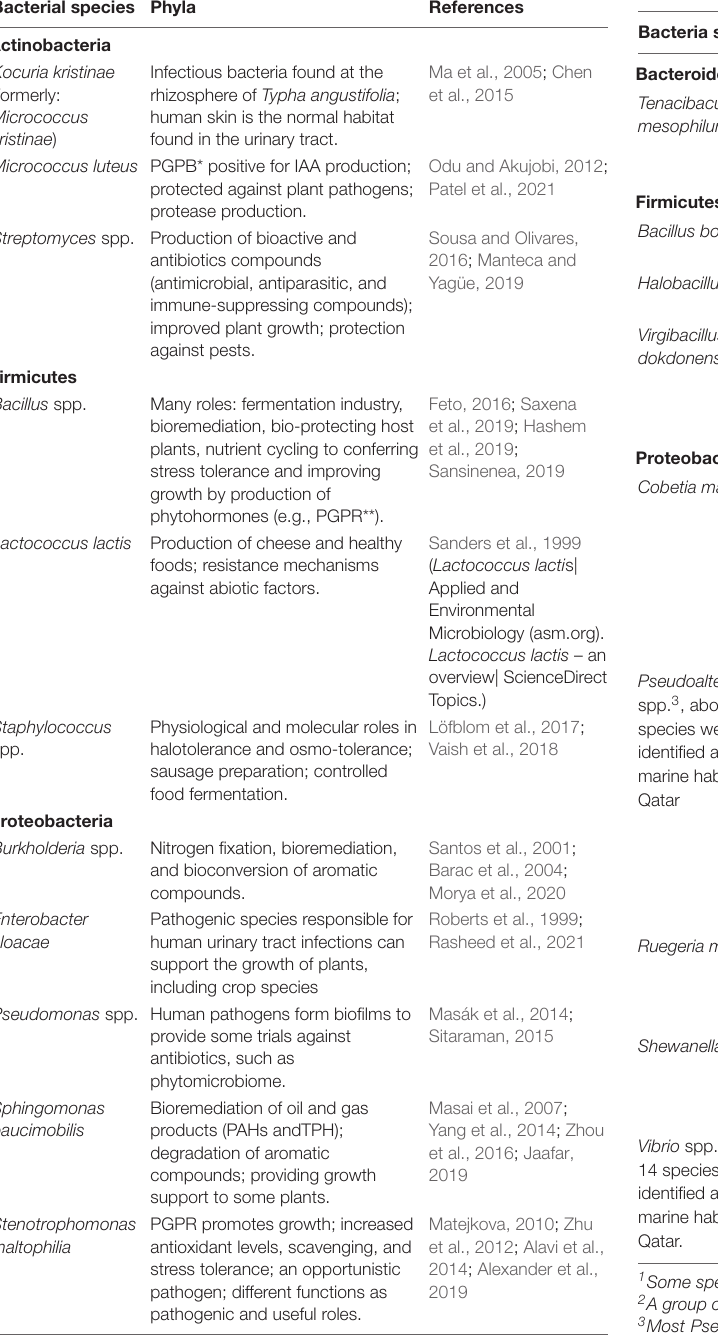
TABLE 5 | The reported roles of the bacterial species found at the Arabian Gulf –